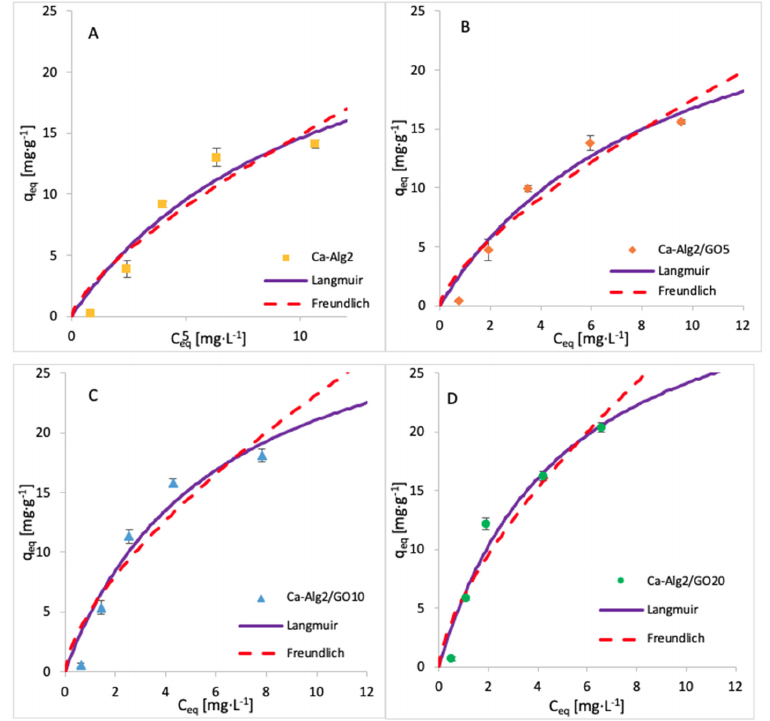
Figure 15. Adsorption isotherms of DFC using ( A ) Ca-Alg2, ( B) Ca-Alg2/GO5, ( C ) Ca-Alg2/GO10 and ( D ) Ca-Alg2/GO20 dried